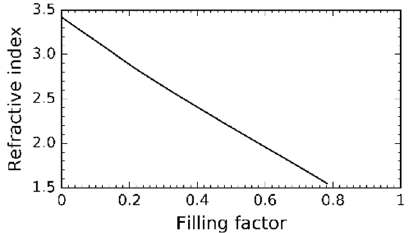
Figure 3. Refractive index of the EM section as a function of the hole diameter.